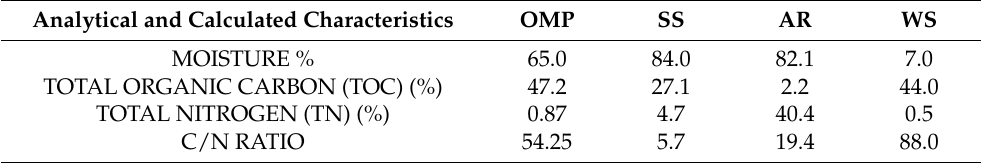
Table 2. Analytical and calculated characteristics of the residues used in the experiment. Olive mill pomace, partially destoned (OMP), sewage sludge (SS), artichoke residues (AR), and wheat straw (WS).